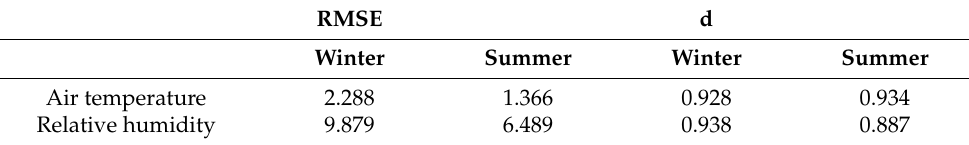
Table 4. RMSE and d-values about air temperature and relative humidity.